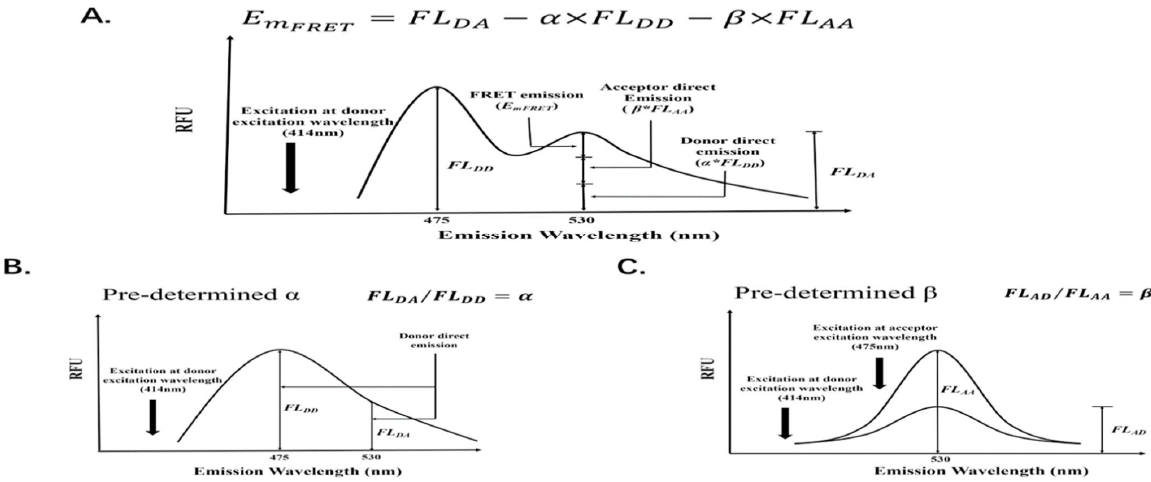
Figure 2. Quantitative FRET signal analysis: ( A ). Fluorescent emission of FRET donor and acceptor mixture at 530 nm, when excited at 414 nm (FL DA ), can be divided into three components: FRET emission from donor, direct emission of donor, and direct emission of acceptor; ( B ). The cross-wavelength correlation coefficiency of donor α is defined as the fluorescent emission of donor at 530 nm, when excited at 414 nm (FL DA ), divided by the fluorescent emission of donor at 475 nm, when excited at 475 nm (FL AA ); ( C ). The cross-wavelength correlation coefficiency β of the acceptor is defined as the fluorescent emission of donor at 530 nm, when excited at 414 nm (FL AD ), divided by the fluorescent emission of donor at 530 nm, when excited at 475 nm (FL AA ).